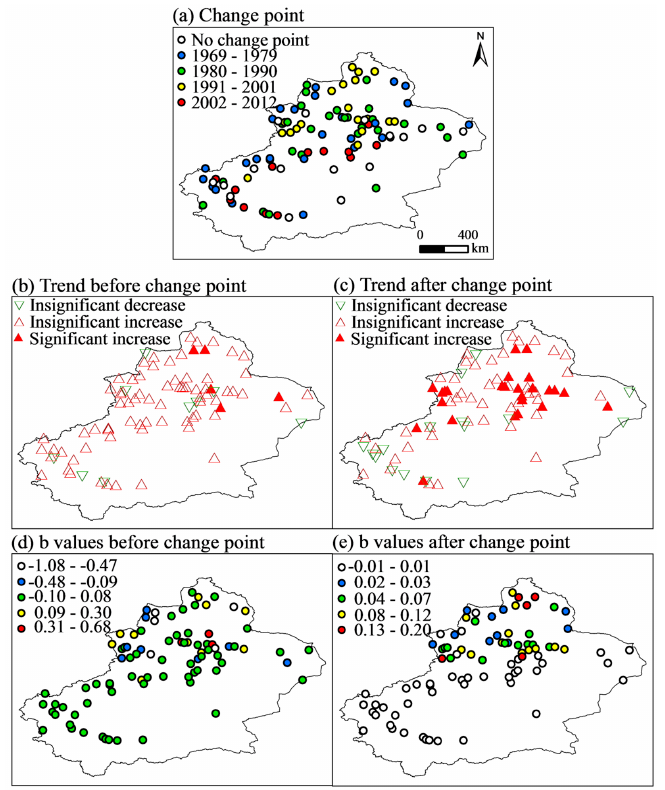
Figure 8. The spatial distribution of the change points, trends and magnitude ( b values) before and after the change points: ( a ) Change point, ( b ) Trend before change point, ( c ) Trend after change point, ( d ) b values before change point and ( e ) b values after change point.